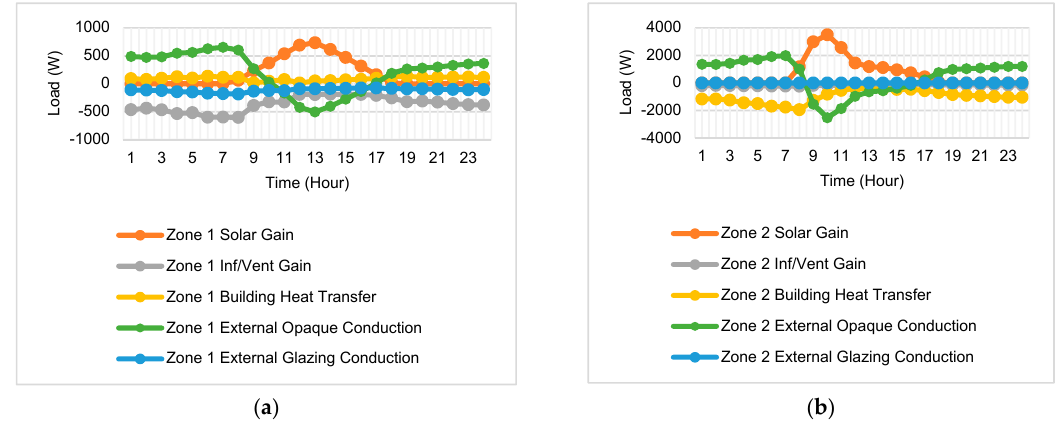
Figure 15. ( a ) Loads breakdown in Al Wafi mosque (Zone 1) during day 20 (winter); ( b ) loads breakdown in Al Wafi mosque (Zone 2) during day 20 (winter).